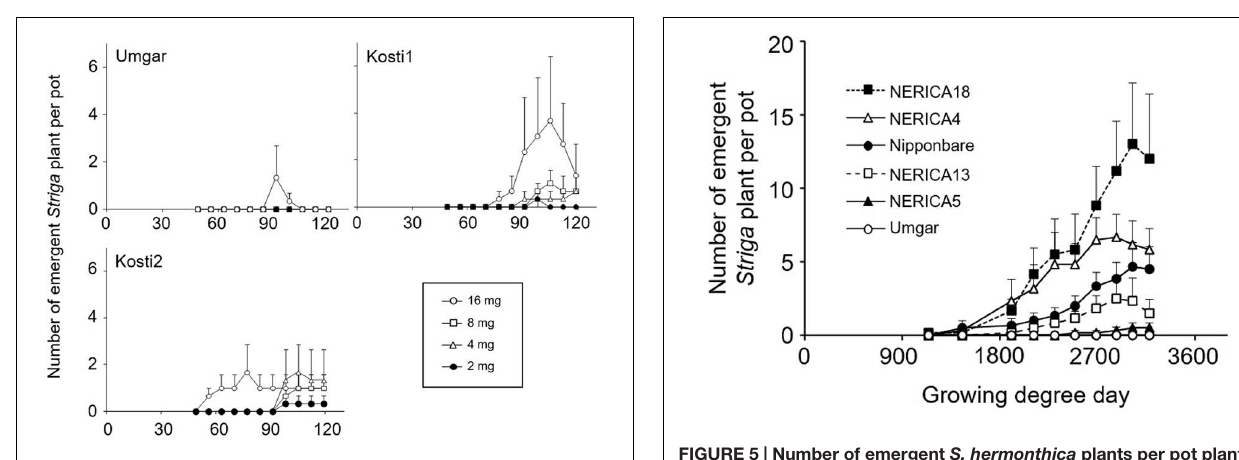
FIGURE 5 | Number of emergent S. hermonthica plants per pot planted with rice. Umgar, NERICA5, NERICA13, Nipponbare, NERICA4, and NERICA18 were used in the second pot experiment. The Striga seeds (16 mg) were mixed into top 5 cm of soil in each pot. Bars indicate standard errors of each mean value of six replications.